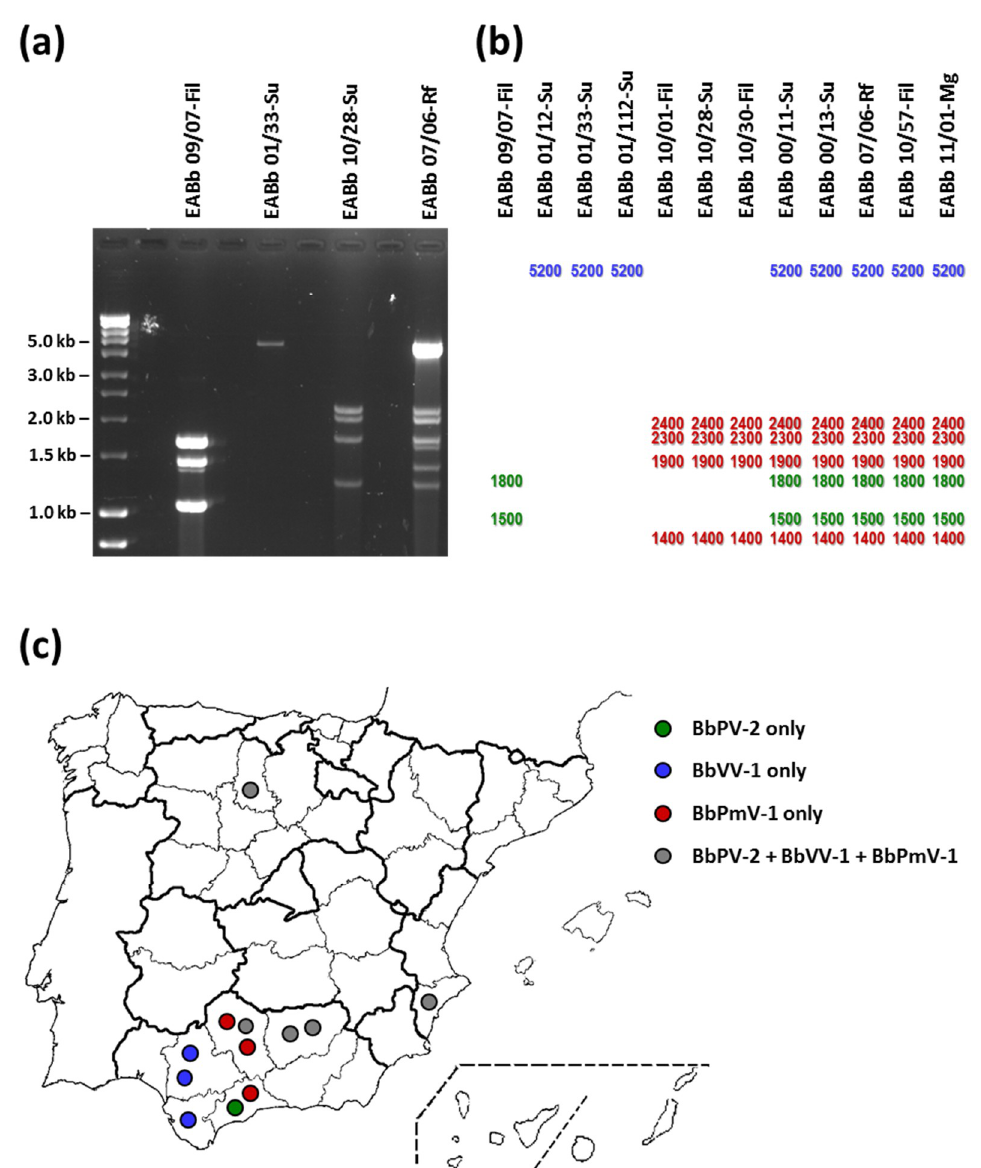
Figure 1. ( a ) 1% ( w / v ) agarose gel electrophoresis of dsRNA elements from four Beauveria bassiana isolates, representative of the four observed electrophoretic profiles. ( b ) Schematic representation of the observed electrophoretic profiles of dsRNA elements isolated from 12 B. bassiana isolates and their relative sizes, green for members of the family Partitiviridae , blue for members of the family Totiviridae and red for members of the proposed family Polymycoviridae. ( c ) Geographical distribution of mycoviruses found in Spanish B. bassiana isolates.